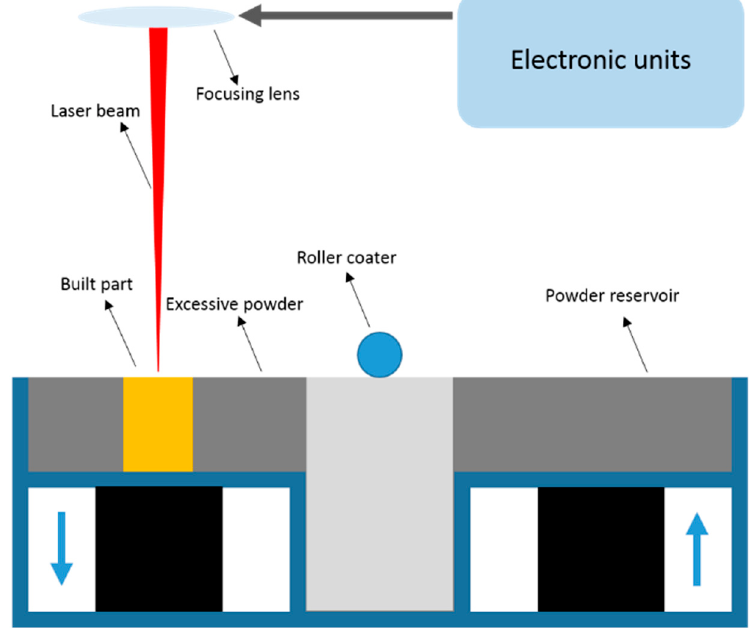
Figure 3. A schematic view of the selective laser melting (SLM) process .